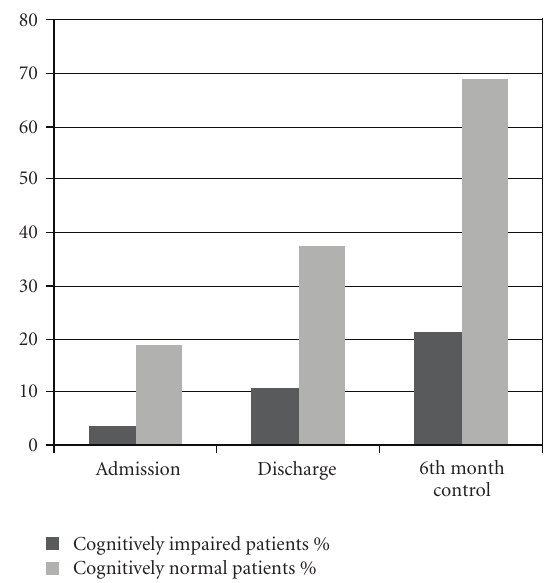
Figure 1: Community ambulation rates of the